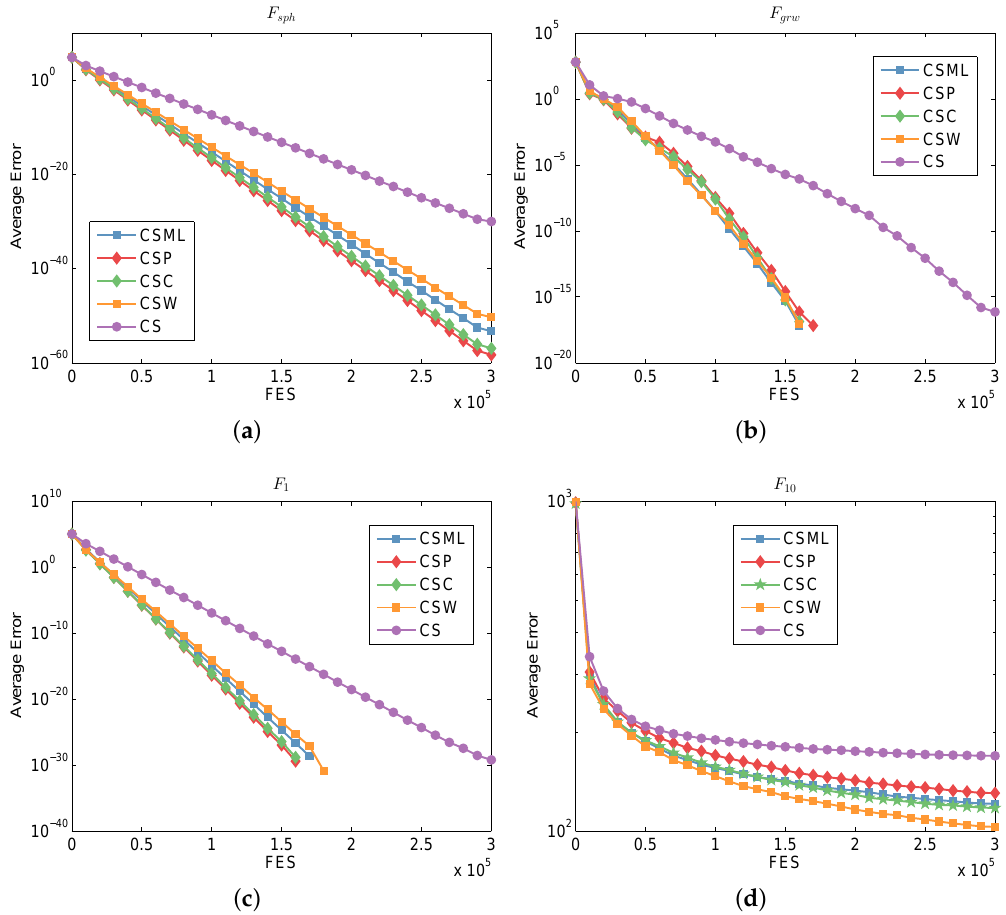
Figure 2. Convergence curves of CS and different improved CS algorithms for selected functions at D = 30. ( a ) Sphere’s Function F sph . ( b ) Griewank’s Function F grw . ( c ) Shifted Sphere Function F 1 . ( d ) Shifted Rotated Rastrigin’s Function F 10